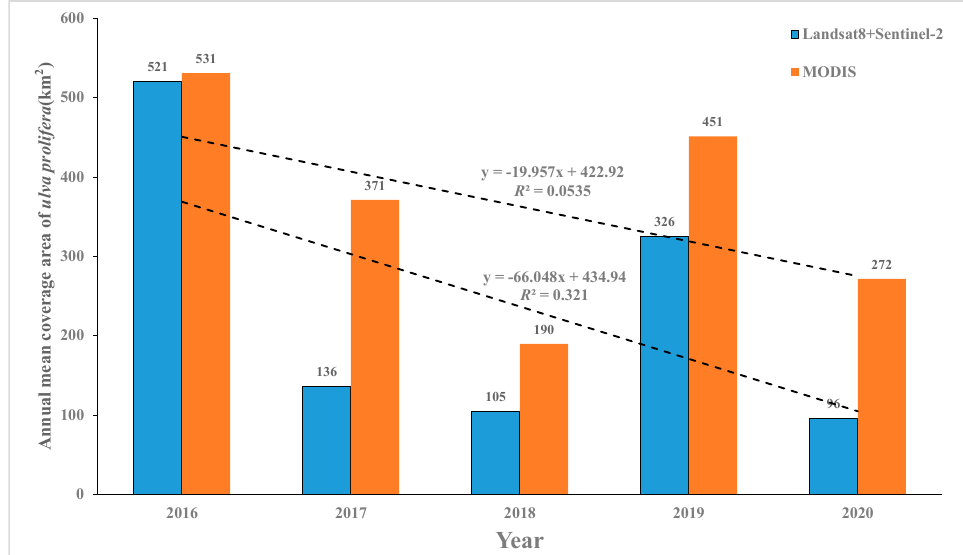
Figure 13. Statistical chart of annual mean coverage area of U. prolifera .